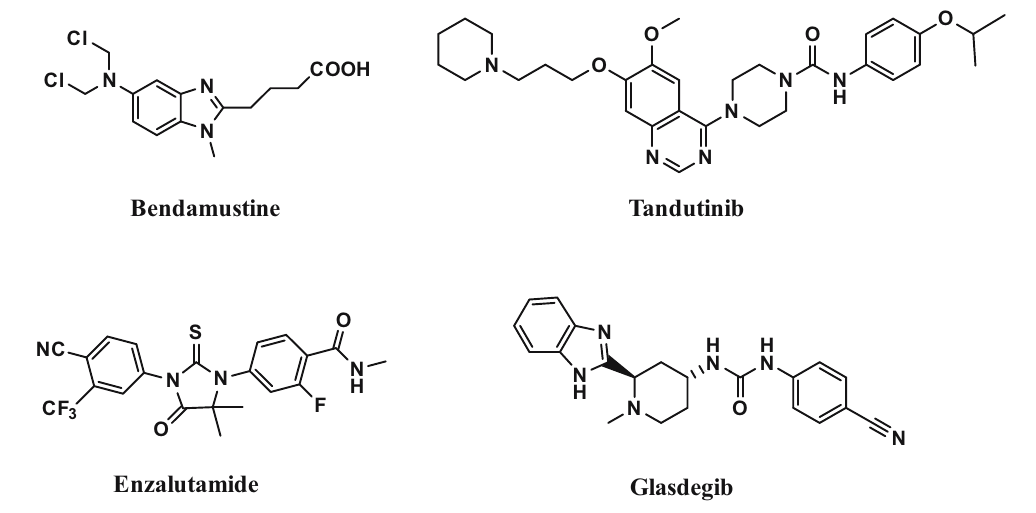
Figure 1: Potent anticancer